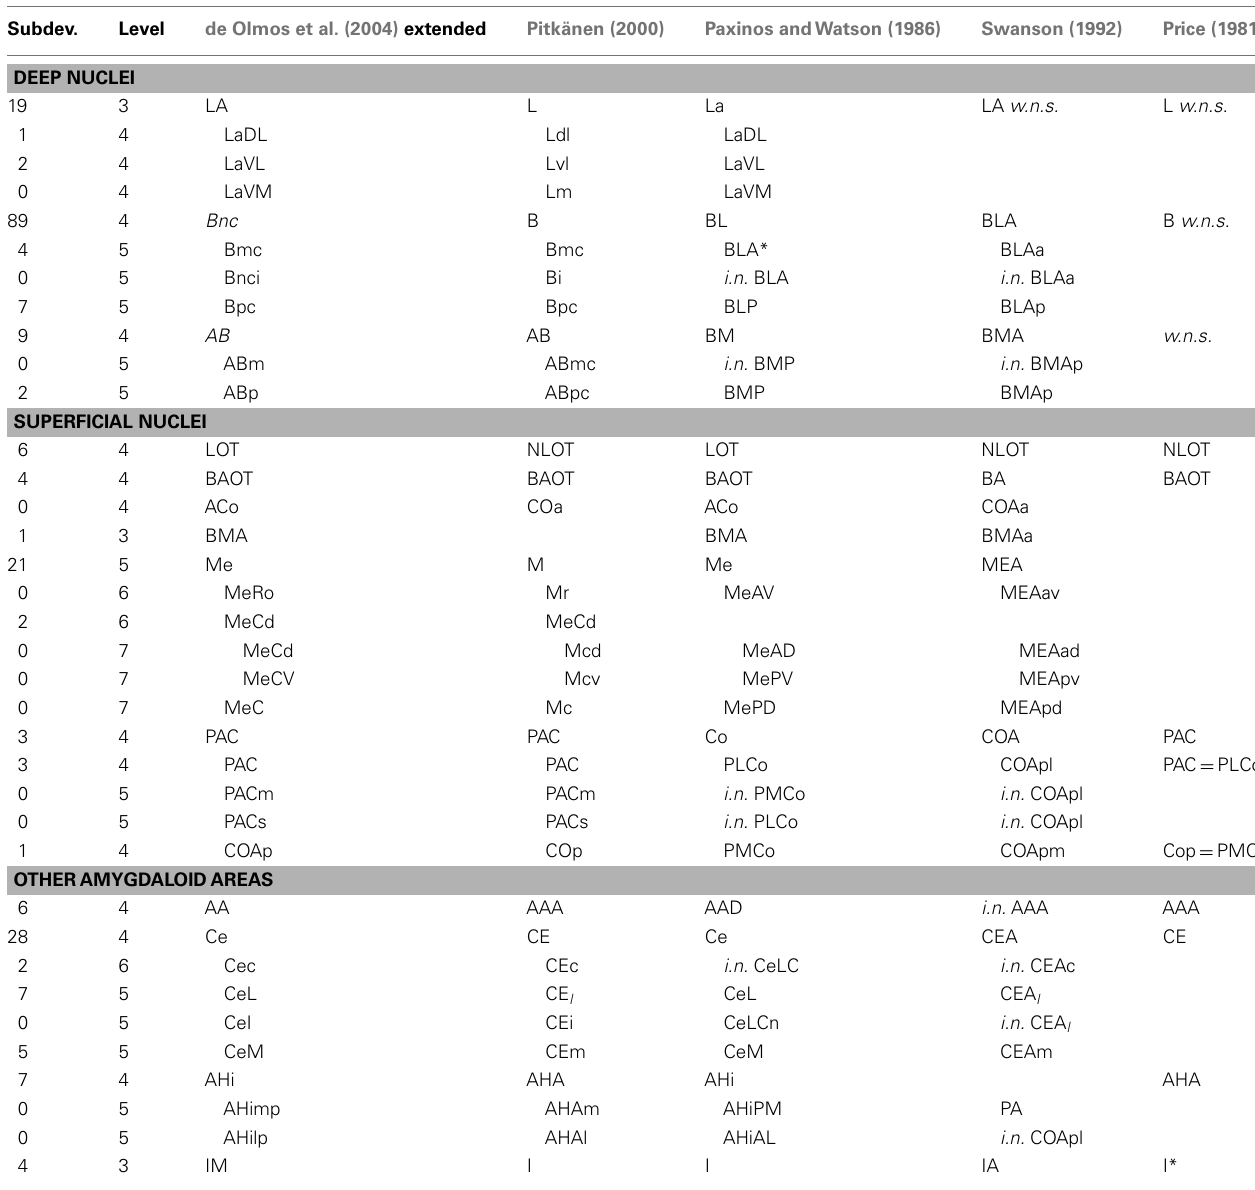
Table 1 | Comparison of amygdala nomenclatures.